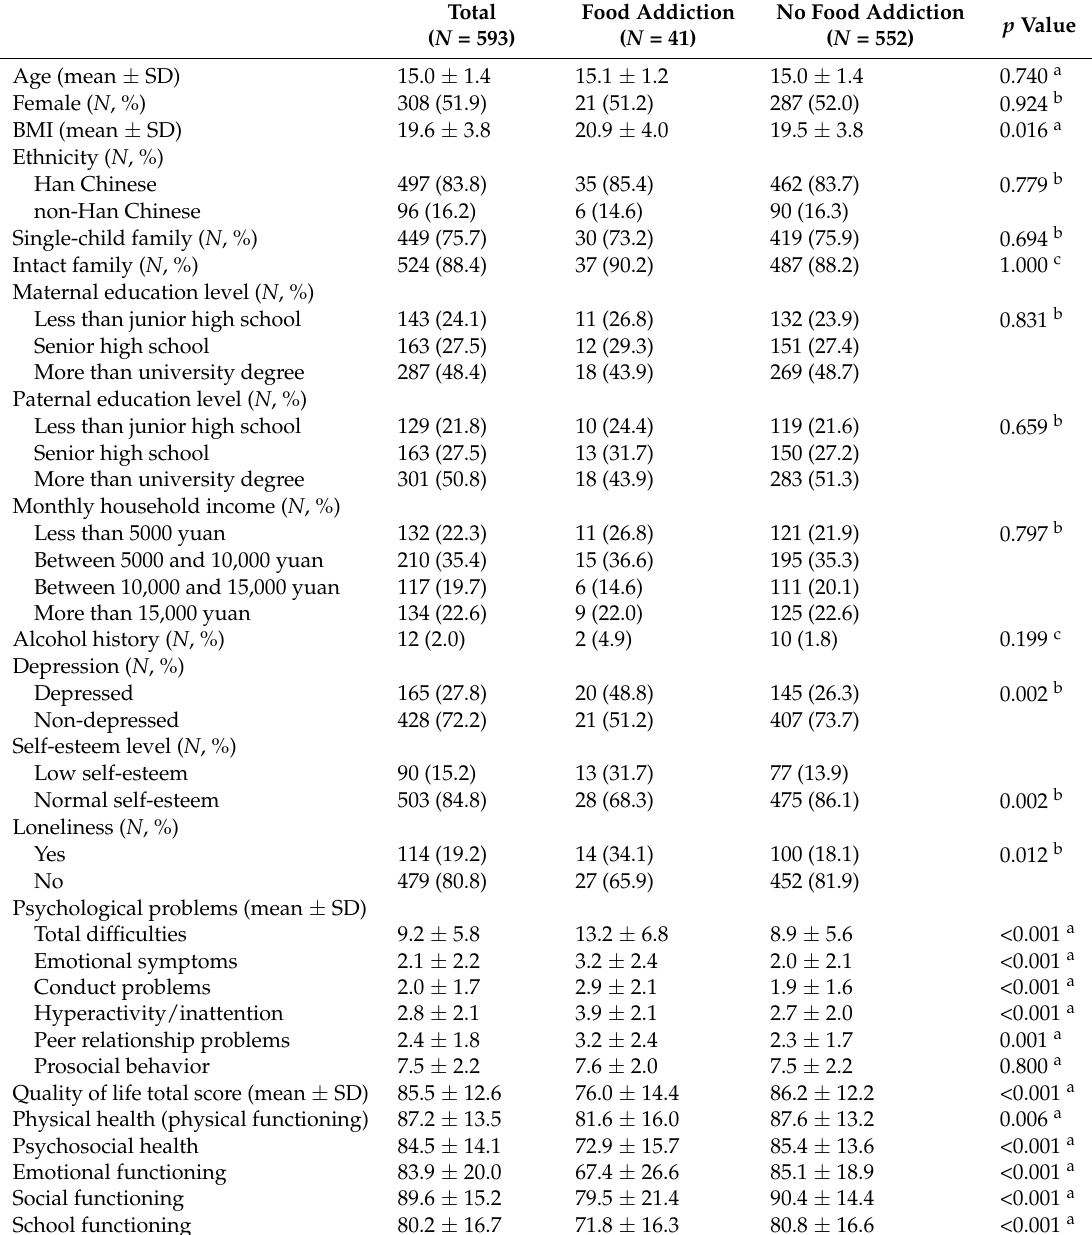
Table 1. Characteristics of participants according to food addiction